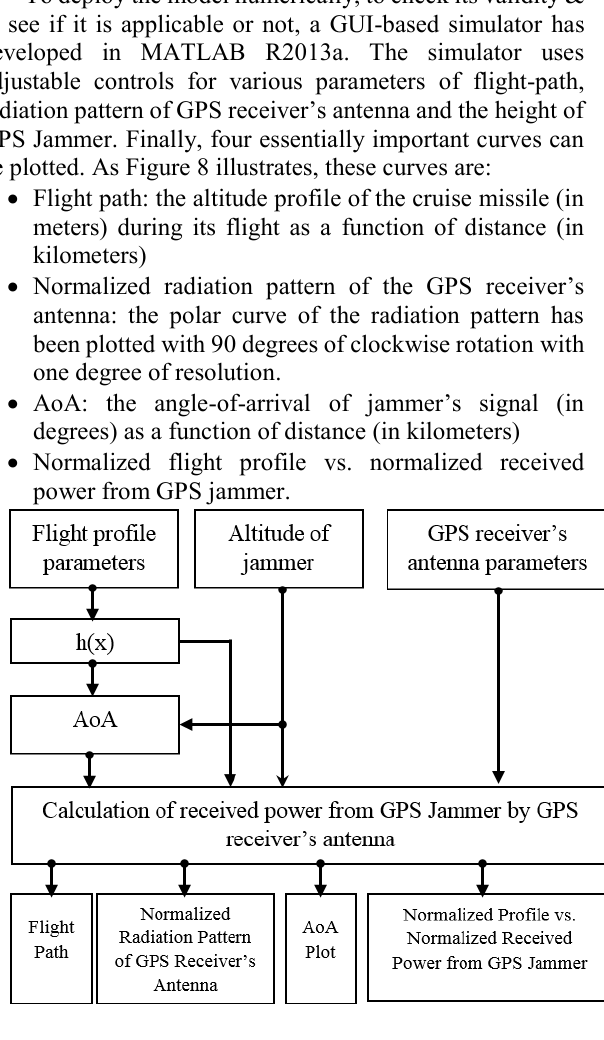
Figure 8. The Overall block diagram of the developed simulation